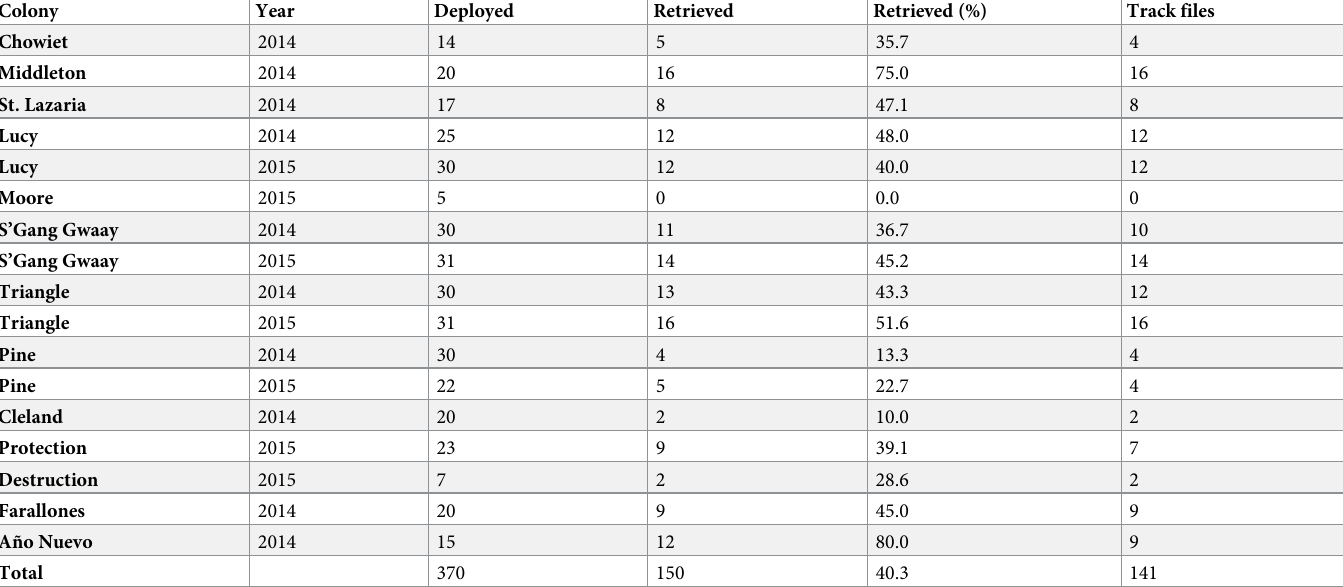
Table 4. Sample sizes and retrieval rates of GLS devices deployed on rhinoceros auklets at breeding colonies along the Pacific Coast of North America, 2014–2015.